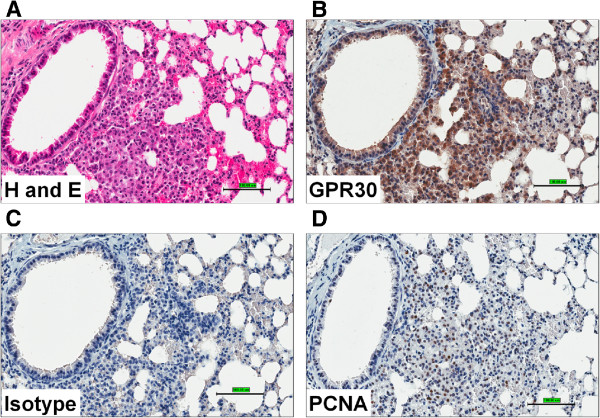
Expression of GPER/GPR30 in mouse lung tumors. (A) IHC analyses of mouse lung cancer (induced with MCA-BHT). The whole lungs were stained with H & E (A), GPR30 C-terminal antibody (Novus Biologicals, 10 μg/ml) (B) along with isotype control (C) and PCNA (D) using standard IHC protocols.